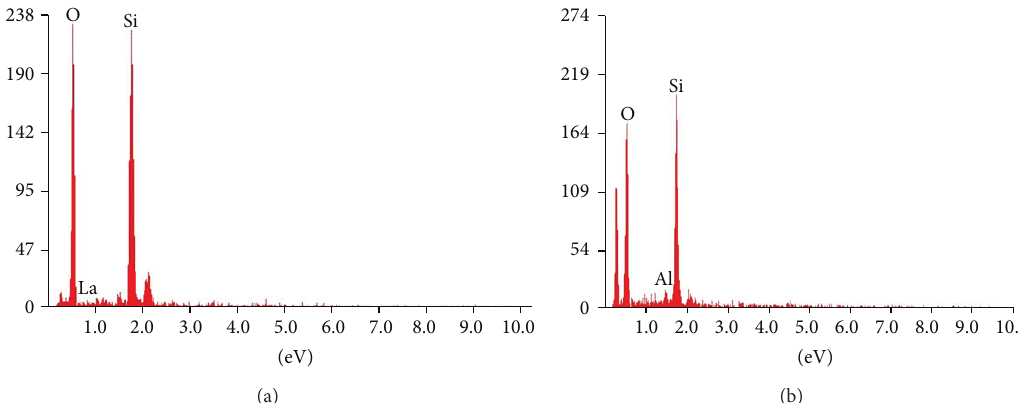
Figure 4: EDAX analysis results for (a) 0.64% La/Ti 4 -NaY and (b) Ti 4 -NaY.